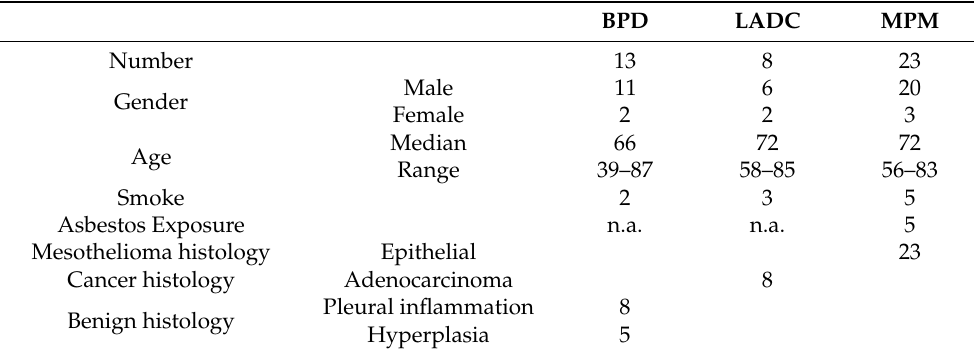
Table 1. Patient demography, smoking habit, and